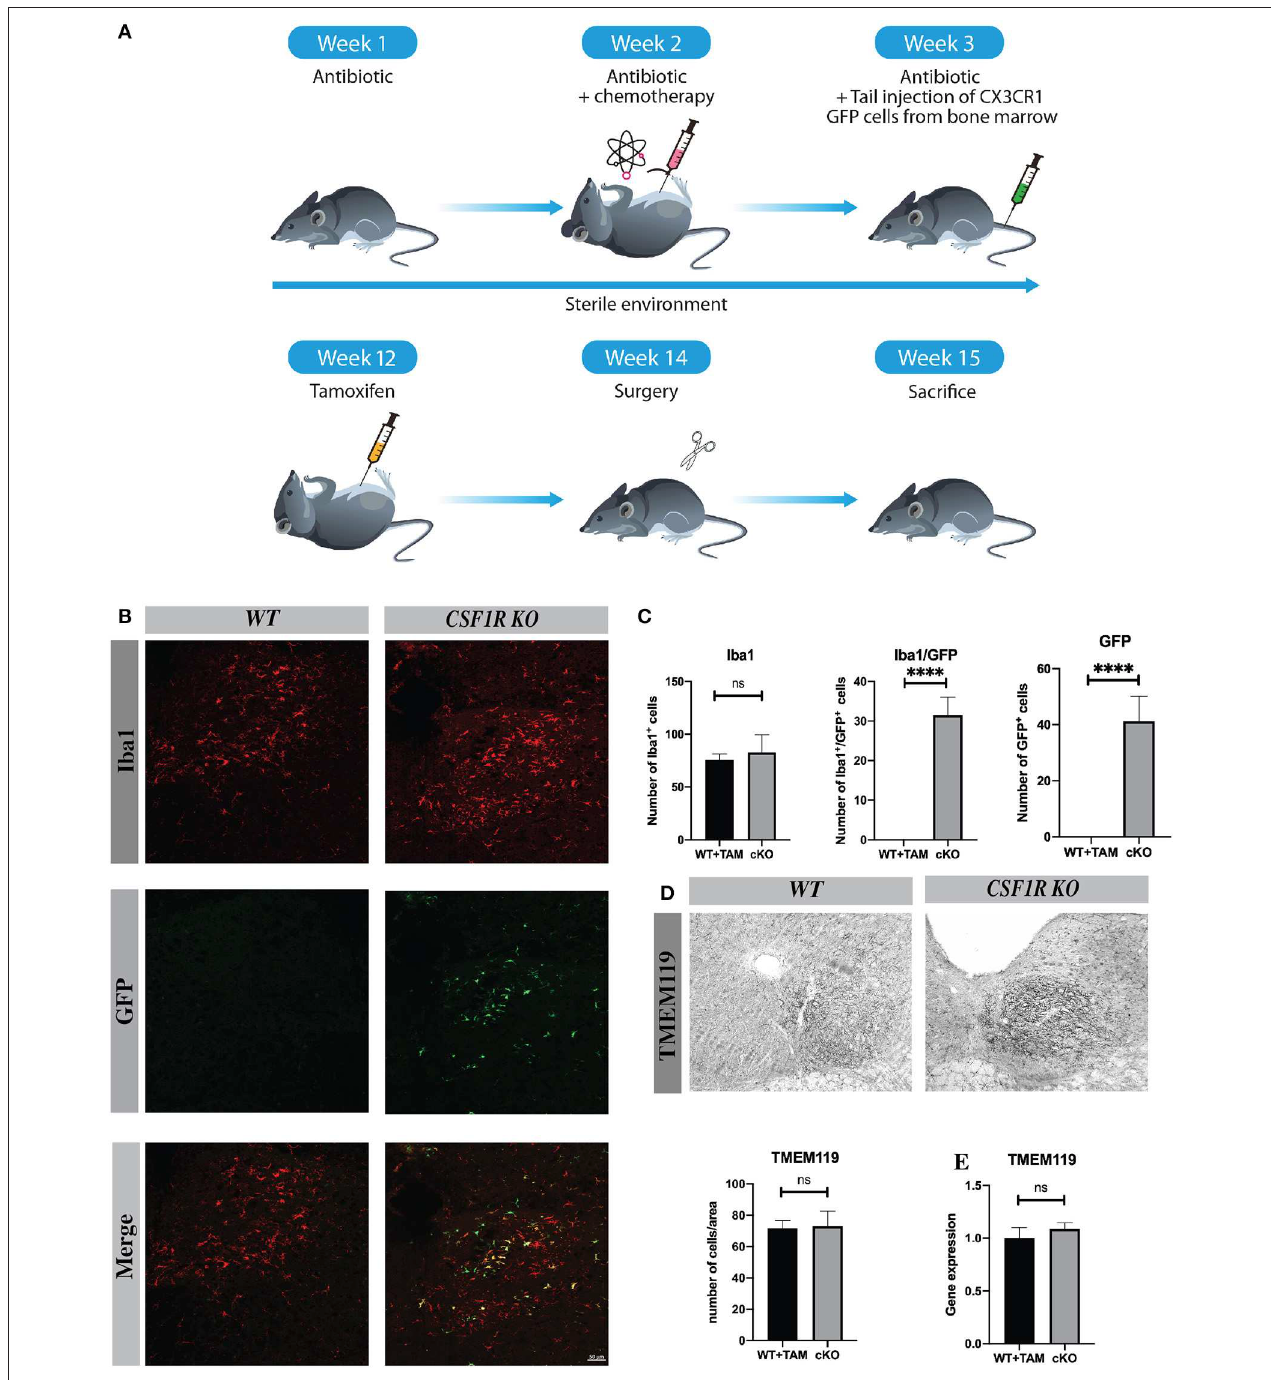
FIGURE 4 | CSF1R depletion induces infiltration of peripheral cells. (A) Scheme of the protocol to initiate chimeric mice. (B) Images of hypoglossal nucleus showing, infiltrating cells (green) and Iba1 positive cells (red), and infiltrating cells/Iba1 (yellow). Scale bar: (A) 50 µ m. (C) The number of Iba1 + , GFP + , and Iba1 + / GFP + was counted in hypoglossal nucleus. (D) Tmem119 staining and cells count in hypoglossal nucleus area (E) Quantification of Tmem119 gene expression in cerebellum by RT-Q-PCR. Values are expressed as mean ± SEM. Statistical analyses were performed using t -test **** p < 0.001 significantly different from cKO group. n = 3–5 mice.